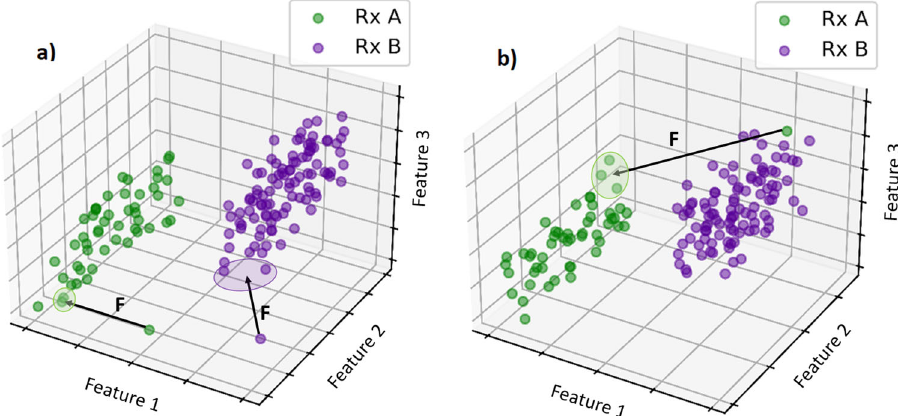
Fig. 4 Illustration of different anomalous cases the model is designed to catch. In a , we show two feature anomalies that are far from the average. In b a case with prescription A is mismatched within the feature sector of prescription B.